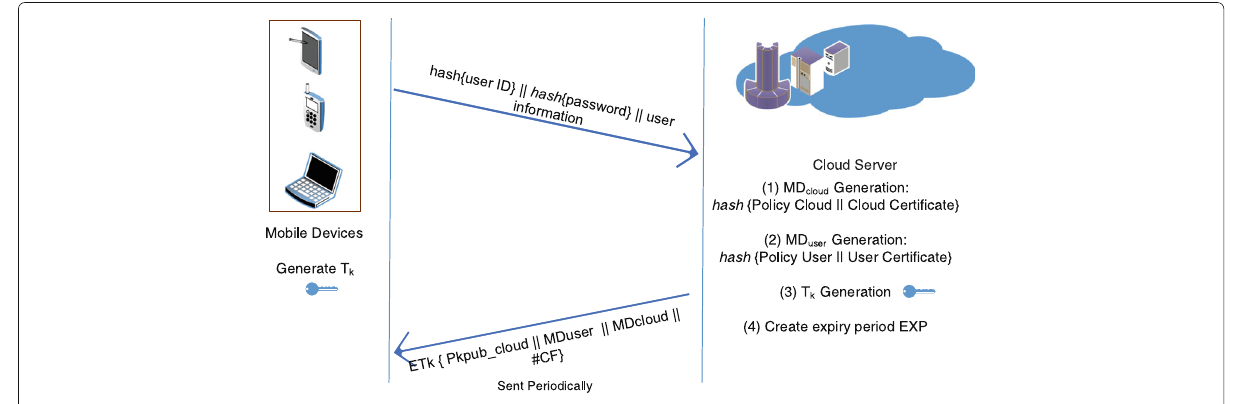
Fig. 1 Registration process of mobile device with cloud server